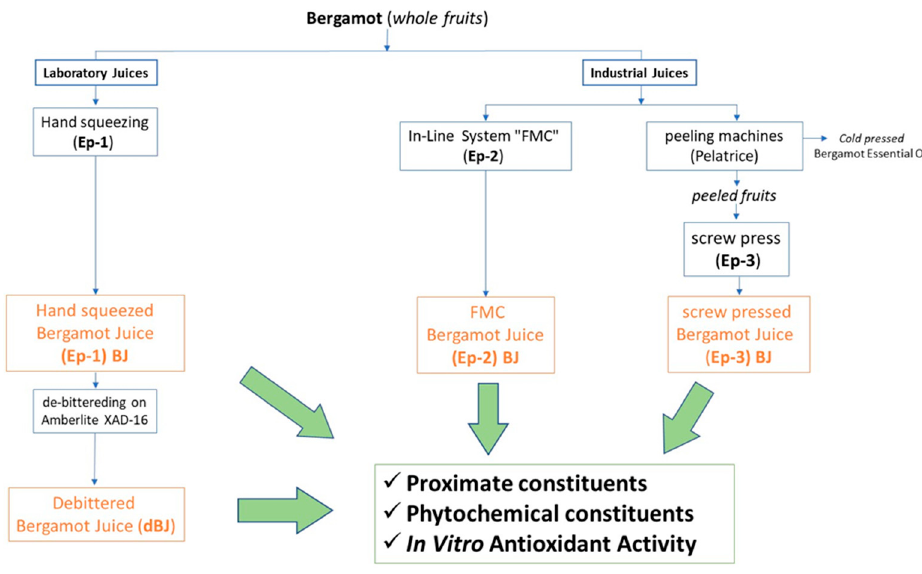
Figure 1. Schematic diagram showing the experimental design applied in this study.